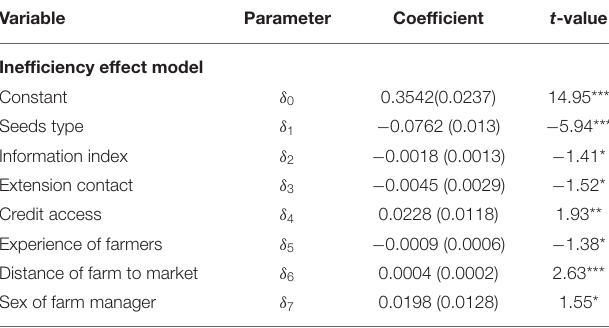
TABLE 4 | Determinants of profit